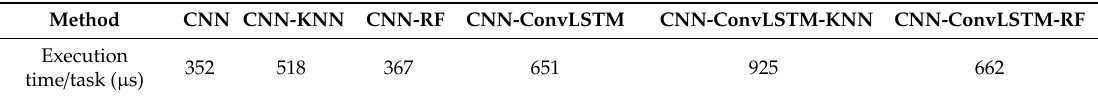
Table 7. Comparison of the execution times of the